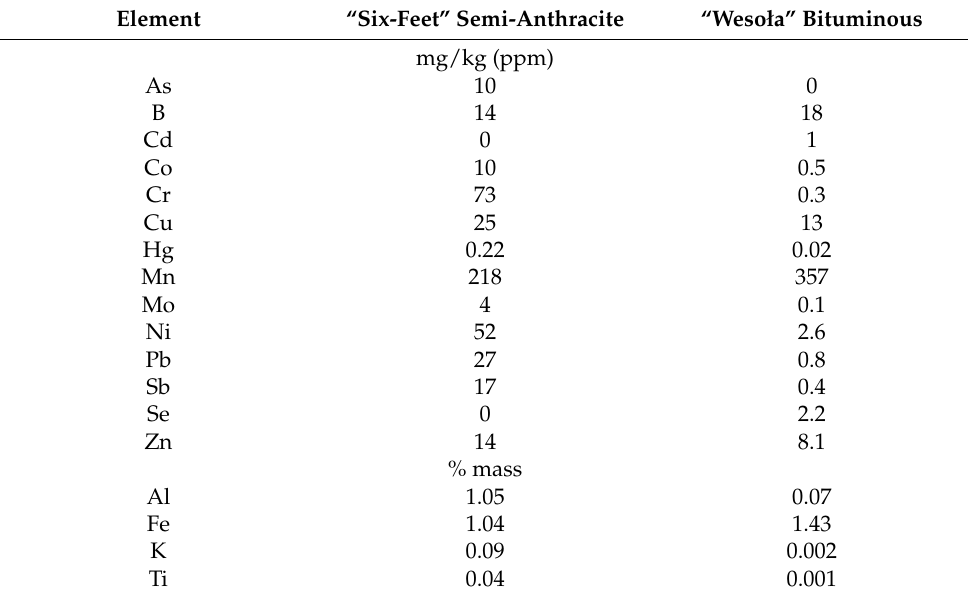
Table 2. Concentrations of metals and metalloids in raw